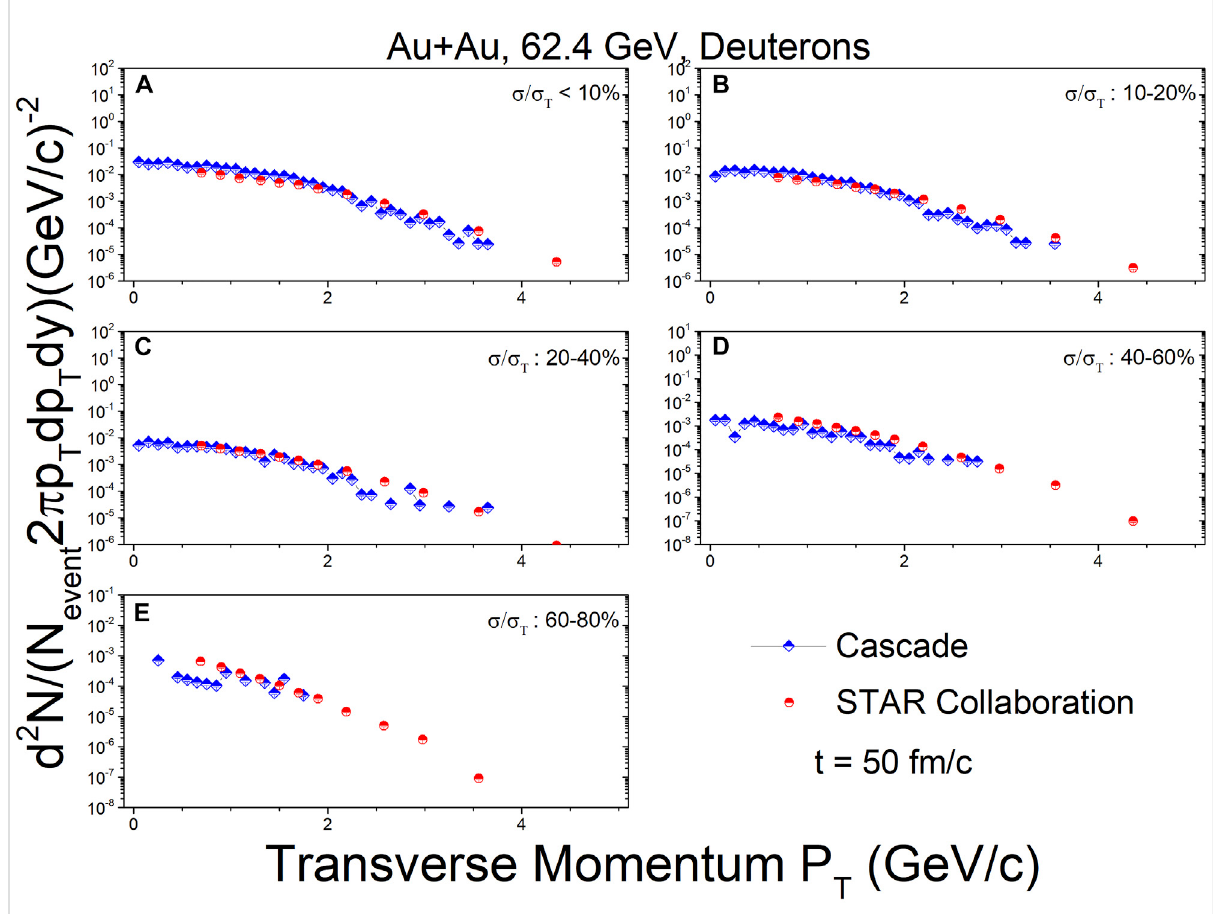
√ (cid:1)(cid:1)(cid:1)(cid:1) s NN = 62.4 GeV Au + Au collisions, 0, − ,10%, 10, − ,20%, 20, − ,40%, 40, − ,60% and 60, − ,80% centrality in t = 50 fm / c in the deuteron In the transverse momentum spectrum. Calculations are represented by signs + lines. Experimental data from the STAR collaboration [27] are represented as circles. The parameter sets of ( R 0 , P 0 ) is (3.8 fm, 0.3 GeV/ c